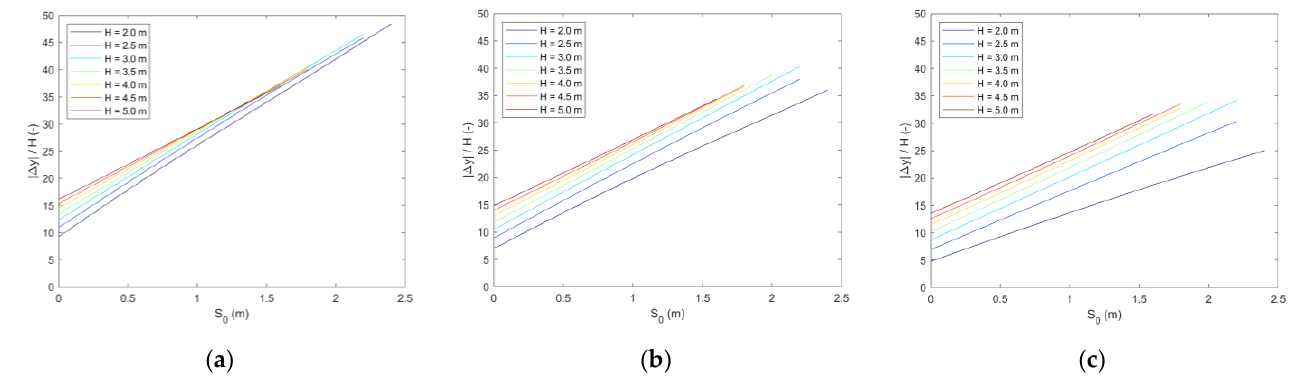
Figure 7. Dimensionless erosion (| Δ y|/H 0 ) for free beaches with different slopes: ( a ) m = 1/30; ( b ) m = 1/20; ( c ) m = 1/10.